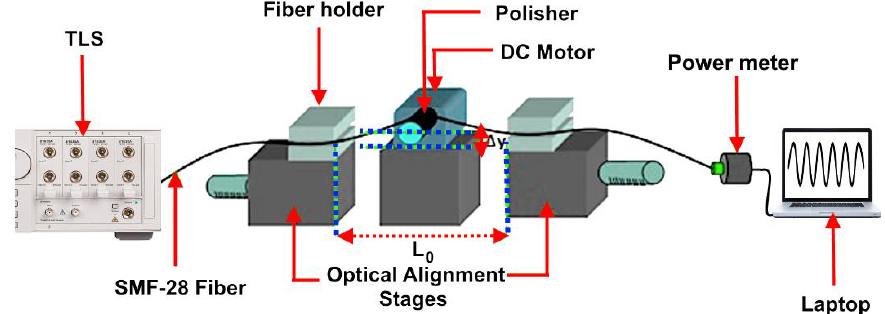
Figure 8. Polisher design setup.